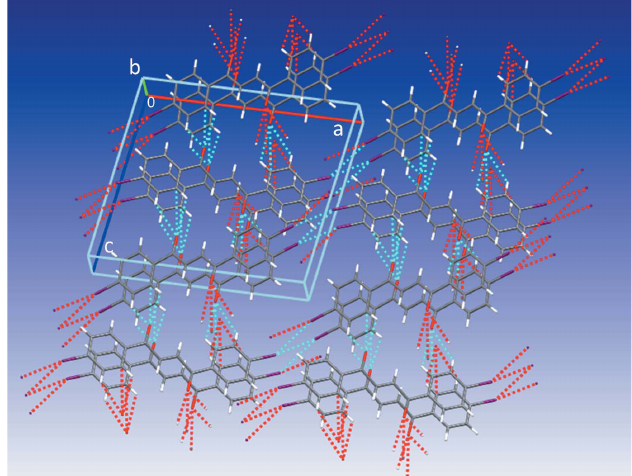
Figure 5 Crystal packing of ( 2 ) along the b axis. Dashed blue lines represent bifurcated Br1 (cid:3)(cid:3)(cid:3) Br1 iv,v interactions [symmetry codes: (iv) (cid:4) x , (cid:4) 1 3 (cid:4) z ; (v) (cid:4) x , 1 (cid:4) z ] and trifurcated interactions involving the O1 + y , 3 2 2 2 atoms.